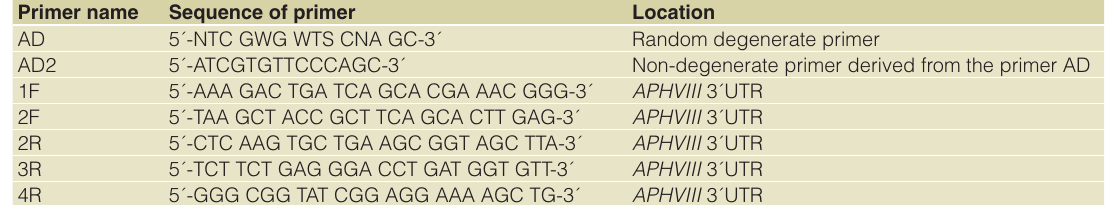
Table 1. List of primers used for Thermal Asymmetric InterLaced (TAIL) PCR, verification of TAIL-PCR product and DNA sequencing. These primers were used to generate the data in Figure 3 and Figure